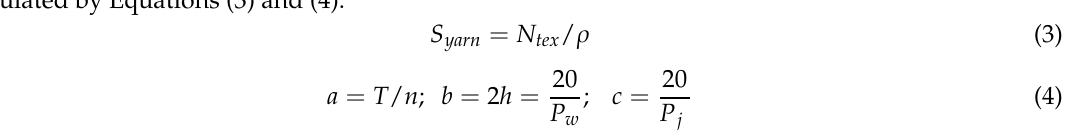
Figure 1. ( a ) Unit cells of 3D fabrics; ( b ) the warp or z-yarn path; ( c ) the simplified model of the unit cell.